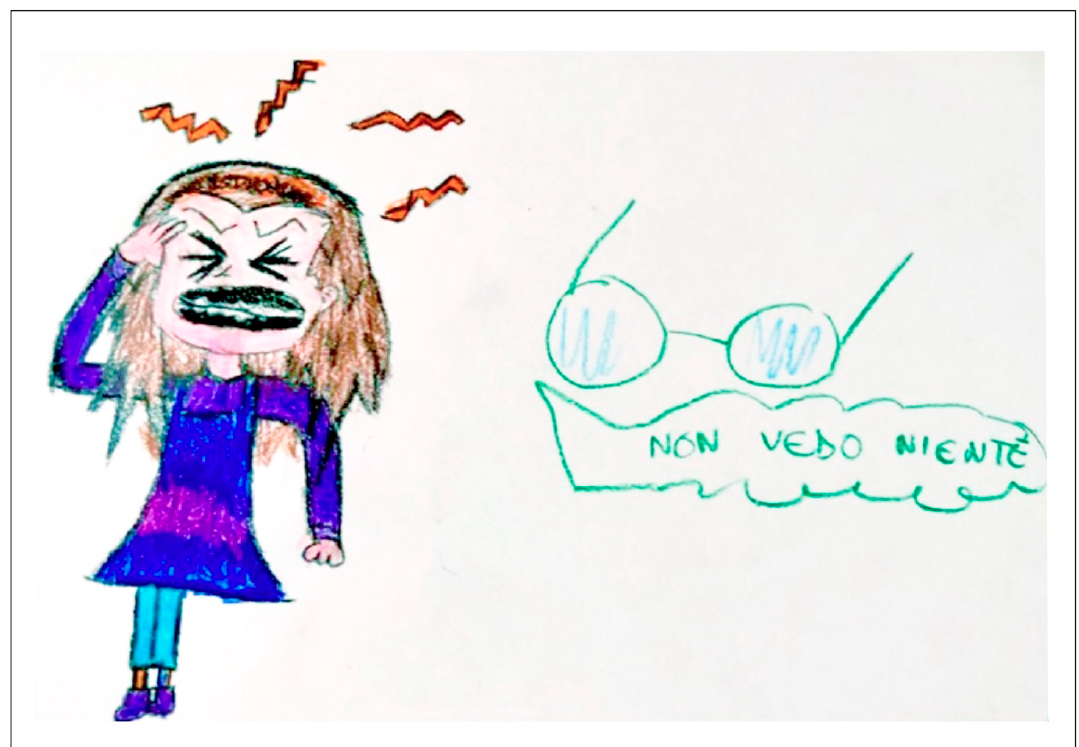
Figure 2. Graphical representation of blindness. We report explanatory drawing of blindness, drawn by a child with migraine who visited the Department of Neuropsychiatry of Di Cristina Hospital in Palermo. Translation of the written portion: “I don’t see anything”. (Courtesy of Dr. V. Raieli). Retinal migraine is sporadic among pediatric migraine patients, accounting for <2%; in this disorder, monocular scotoma or vision loss is reported, rather than hemifield deficits typical in the visual aura.